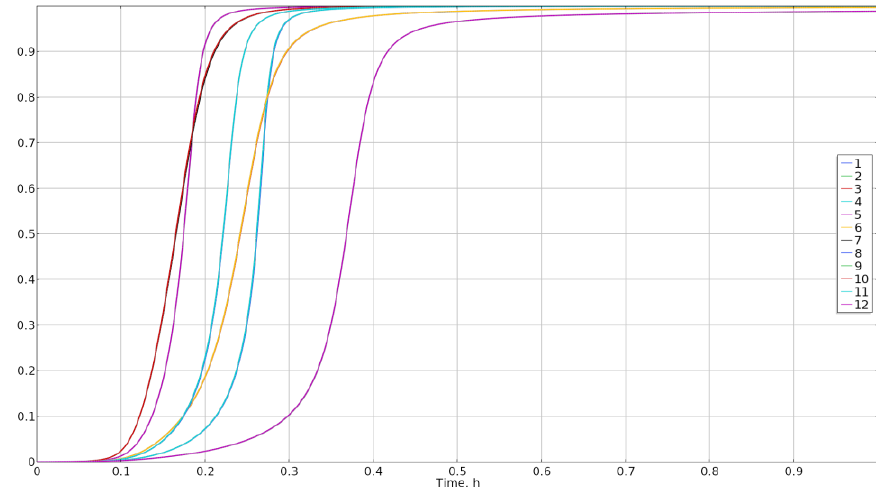
Fig. 4. The dynamics of the degree of cure at control points of the workpiece. Curves 1 – 3 refer to the center, the middle and the top edges of the upper part of the workpiece respectively; curves 4 – 6 are the same for bottom part of the workpiece; curves 7 – 9 and 10 – 12 are the same for the left and right parts of the